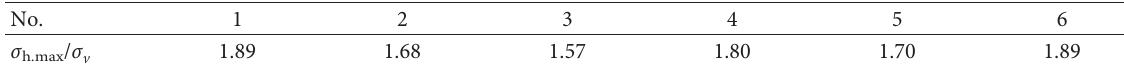
Table 4: Ratio of the maximum horizontal principal stress to vertical principal stress.